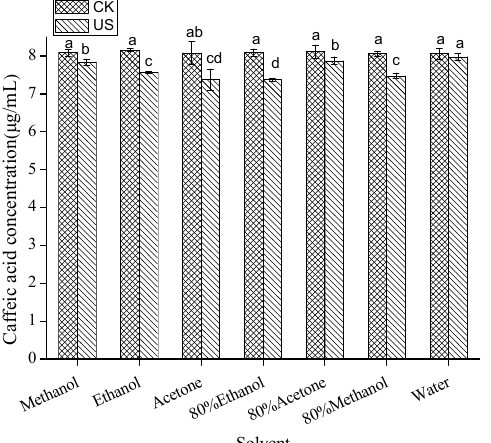
Figure 1. Effect of solvent on the stability of caffeic acid under ultrasound treatment (US) and maceration (CK).